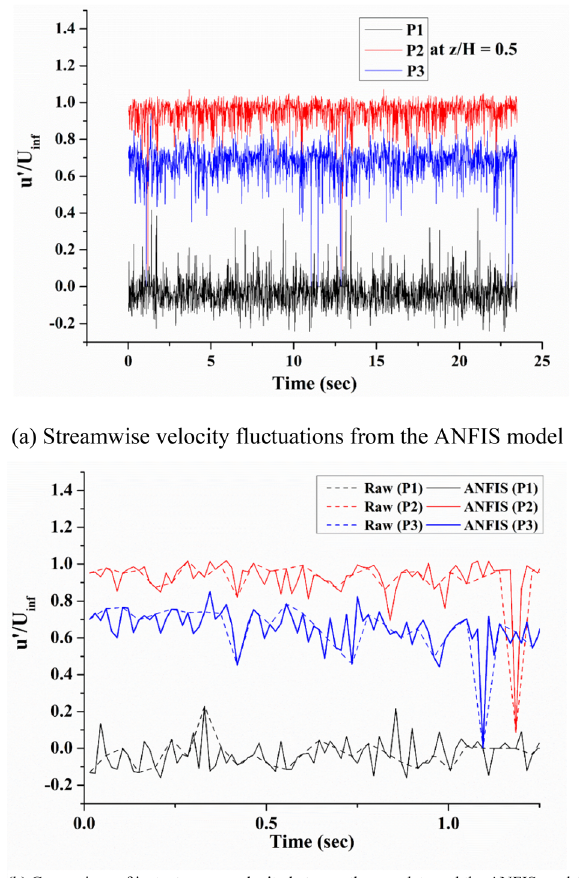
Figure 13. Comparison of the instantaneous streamwise velocity fluctuations between the raw and predicted data taken at P1, P2, and P3 in the horizontal plane at z/H = 0.5 for model